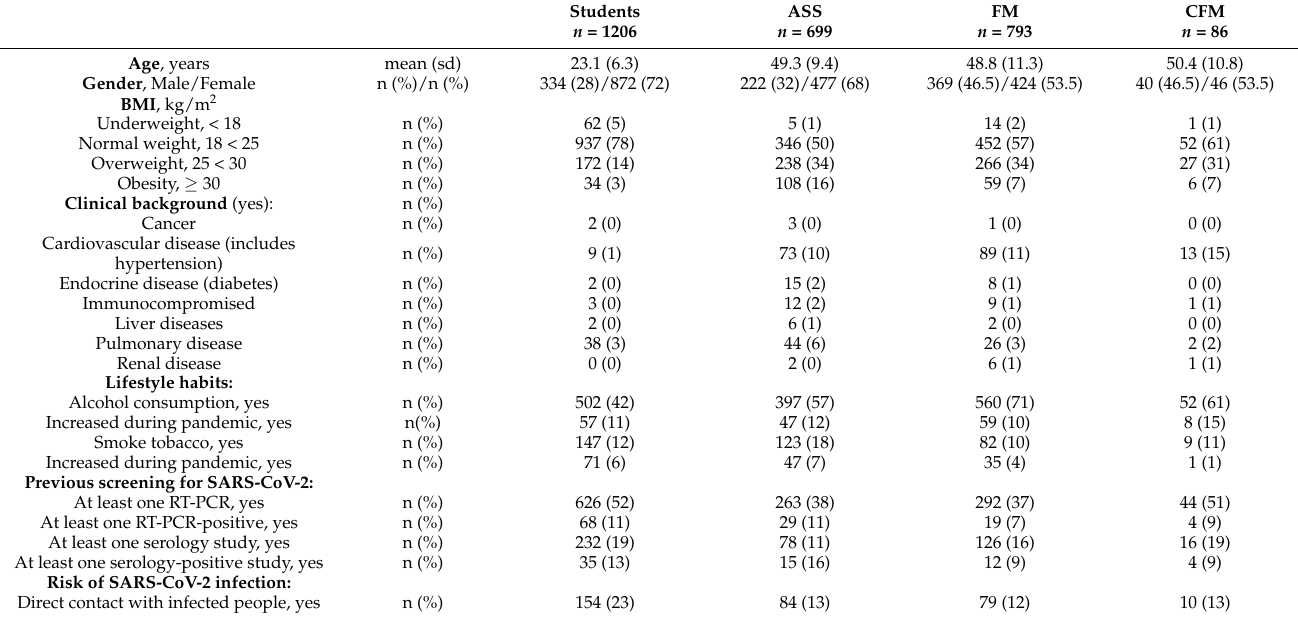
Table 1. Baseline characteristics of participants based on the epidemiological